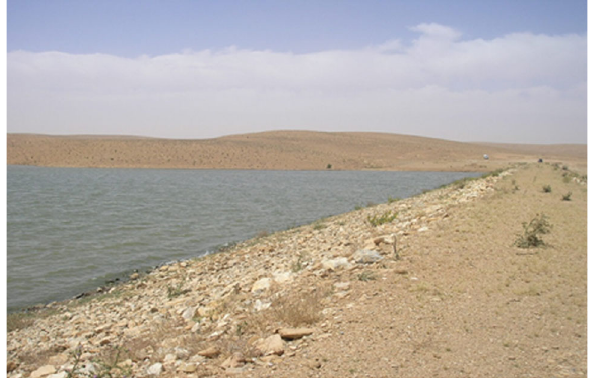
Fig. 1 View of the dam